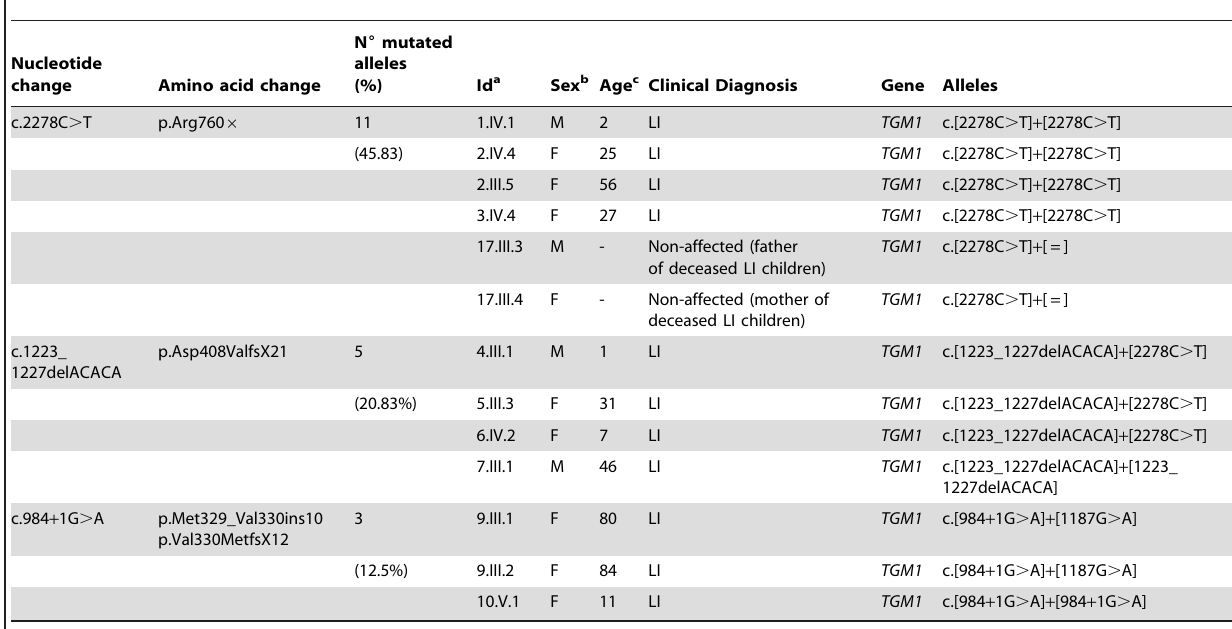
Table 1. Summary of patients and mutation data for c.2278C . T and c.1223_1227delACACA carrier.